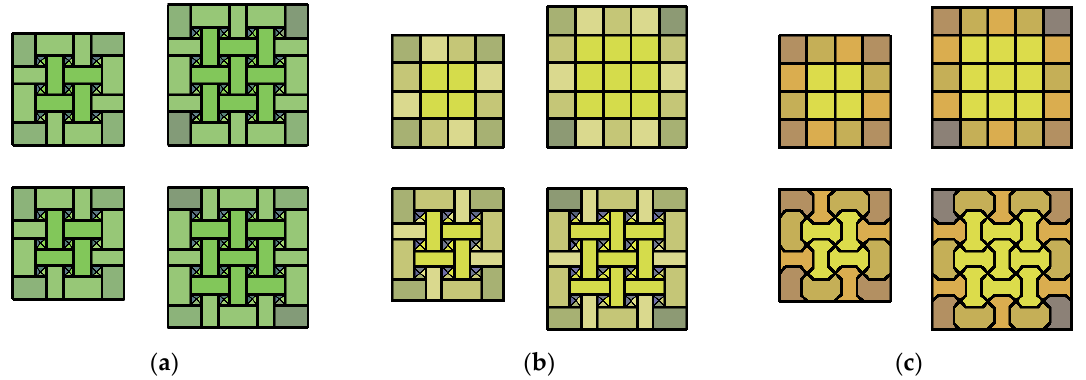
Figure 20. The vaults filling square fields in grillages from beams with vertical faces: ( a ) both sides rugged; ( b ) one side smooth; and ( c ) both sides smooth.